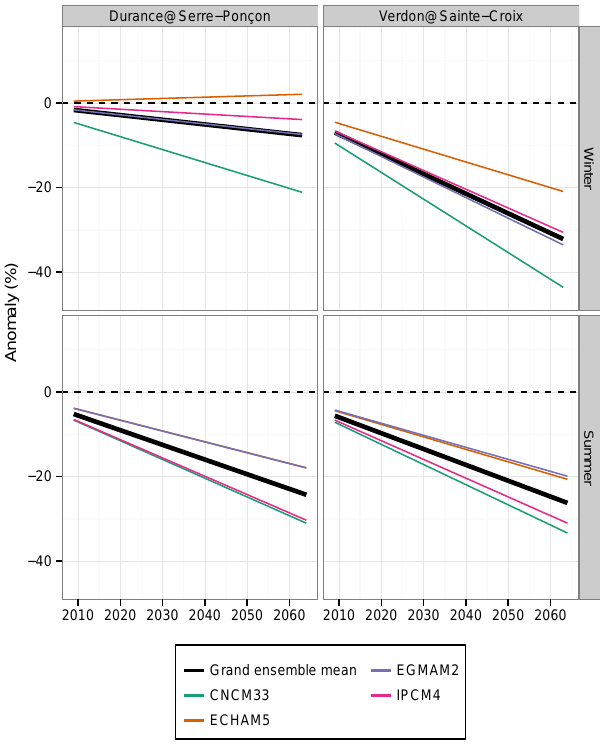
Figure 4. GCM effects on low-flow changes around the grand en- semble mean for both catchments and both